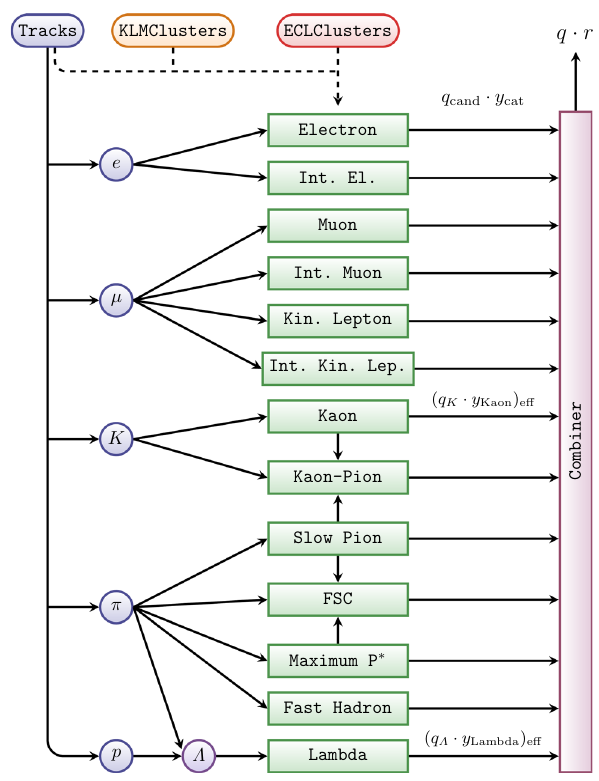
Fig. 1 Schematic overview of the category-based flavor tagger. The tracksonthetagsideareusedtobuildfivedifferentlistsofcandidates: e , μ , K , π , and p . Each category considers the list of candidates belonging to its own targets. The different categories are represented by green boxes, and the combiner by a magenta